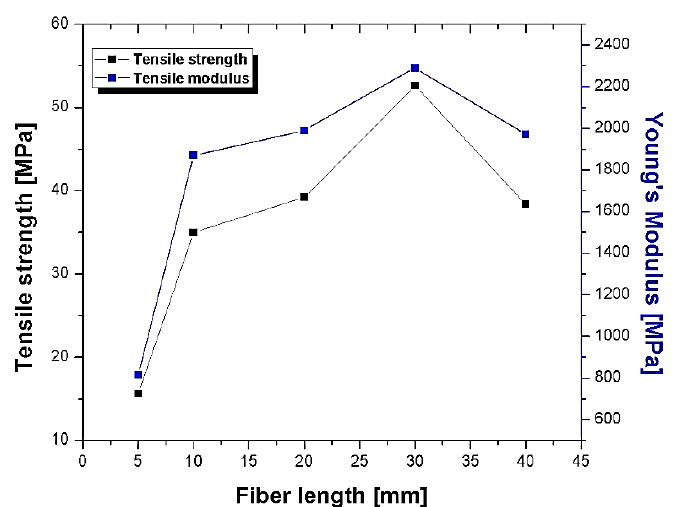
Figure 15. Tensile properties of chopped pineapple leaf fiber (PALF) with different fibre lengths (5–40 mm) at 30 wt. % of PALF reinforced with polyester composite. Adapted with permission from Reference [92]. Copyright 1998, with permission from John Wiley and Sons.